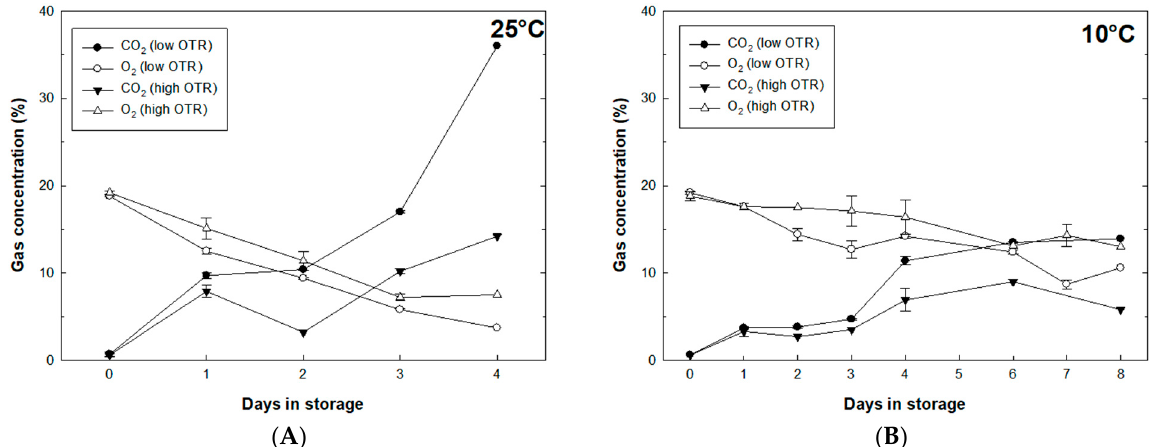
Figure 1. Gas concentration in passive MAP with low and high-OTR films containing ‘Pione’ grapes during storage at 25 °C for 4 days ( A ) and at 10 °C for 8 days ( B ). Vertical lines represent the standard error of the mean ( n = 3). Standard error bars are not shown where masked by the graph symbol.